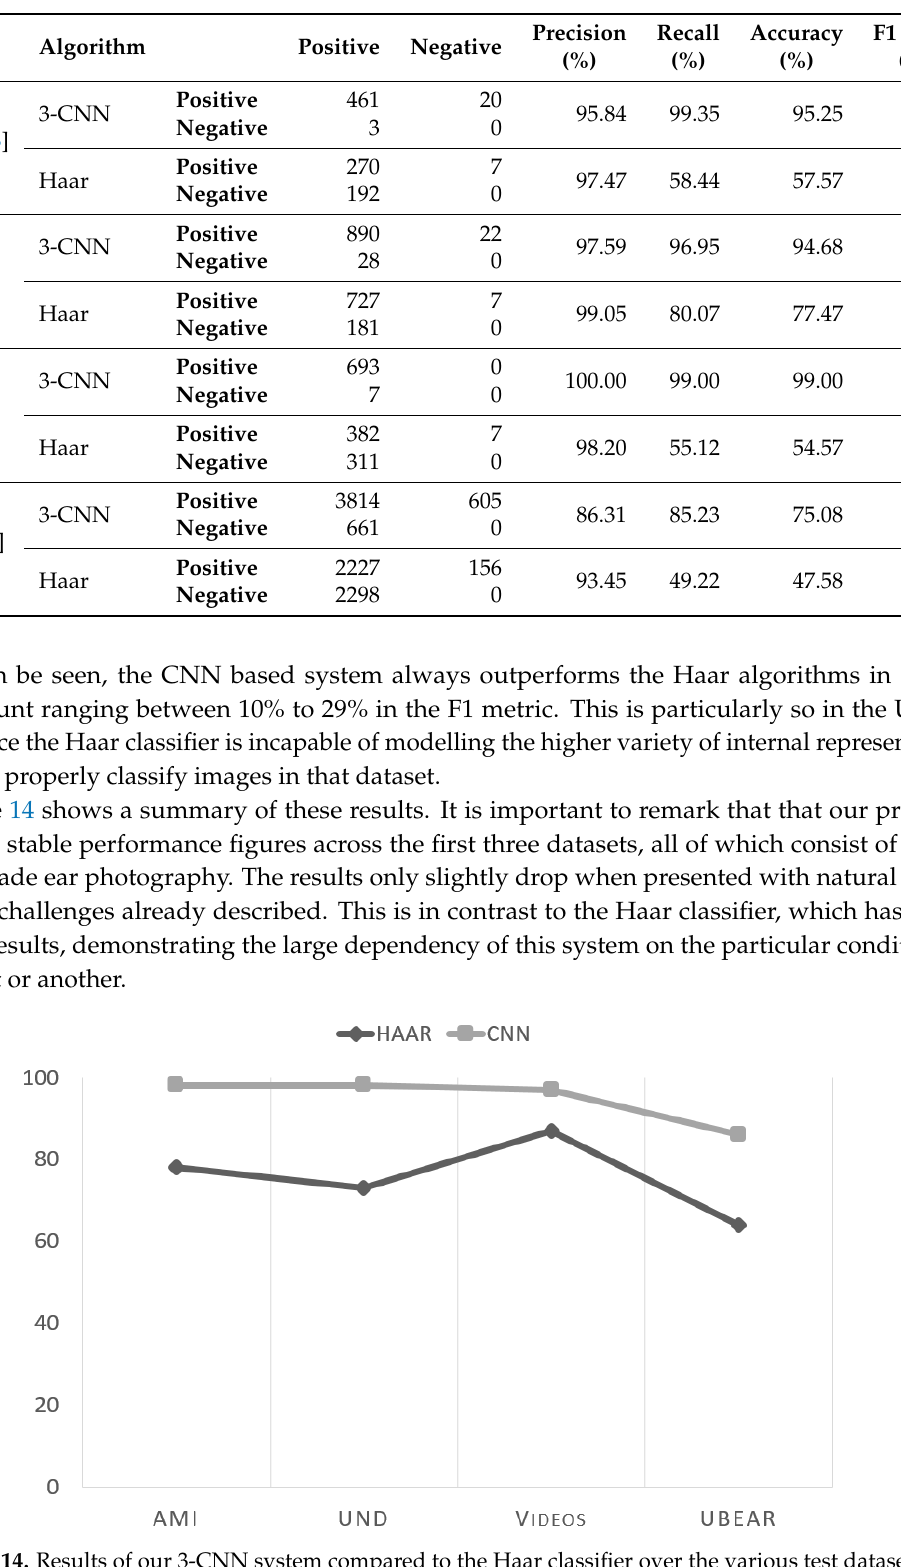
Table 9. Summary of the total results over all four datasets contrasting the Haar and 3-CNN algorithms.